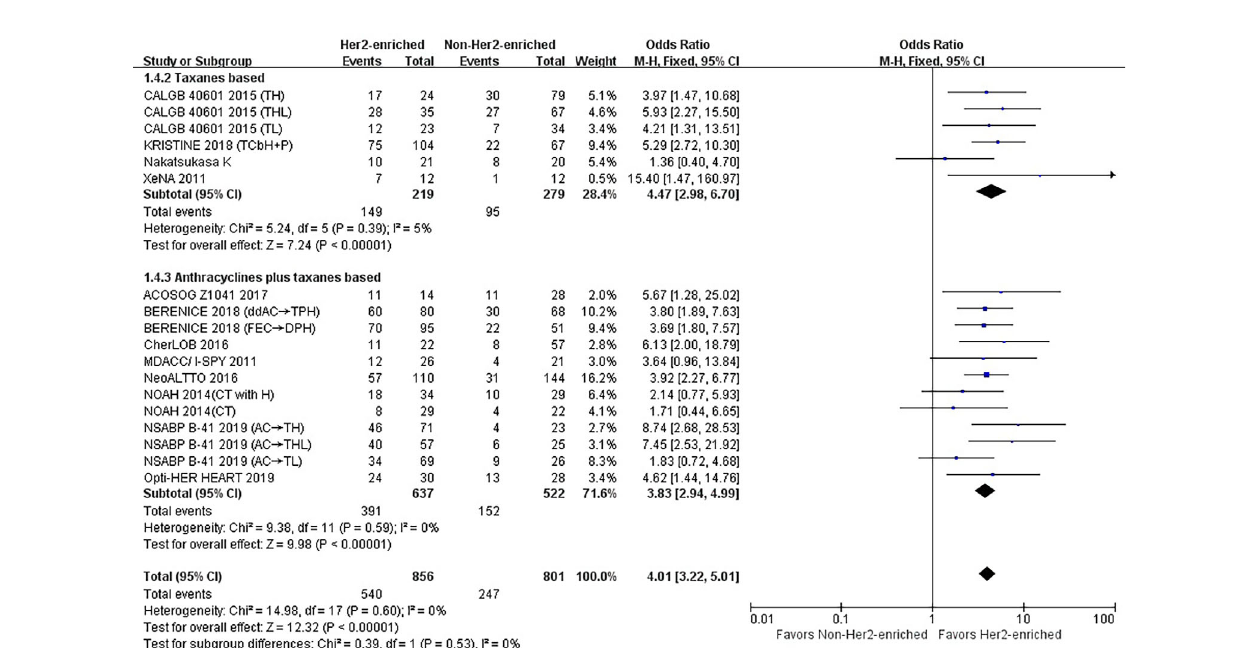
FIGURE 5 | Forrest plot of odds ratio (OR) used to evaluate the correlations between intrinsic molecular subtype subgroups (HER2-enriched vs. non-HER2- enriched) and pCR as based on the type of chemotherapy used. CI, con fi dence interval; HER2, human epithelial growth factor receptor 2; pCR, pathological complete